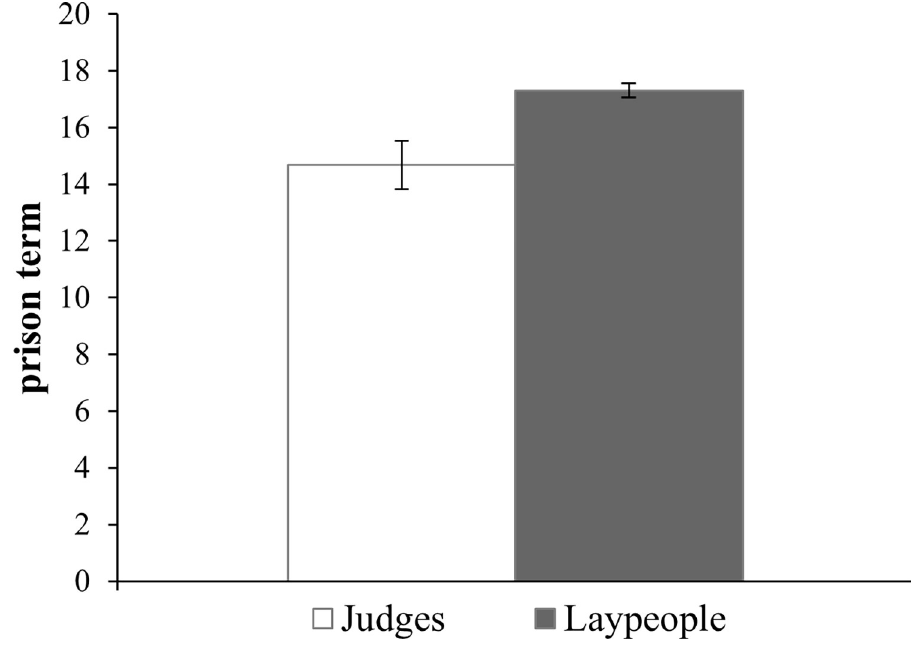
Fig 3. Years of imprisonment suggested (error bars represent the standard